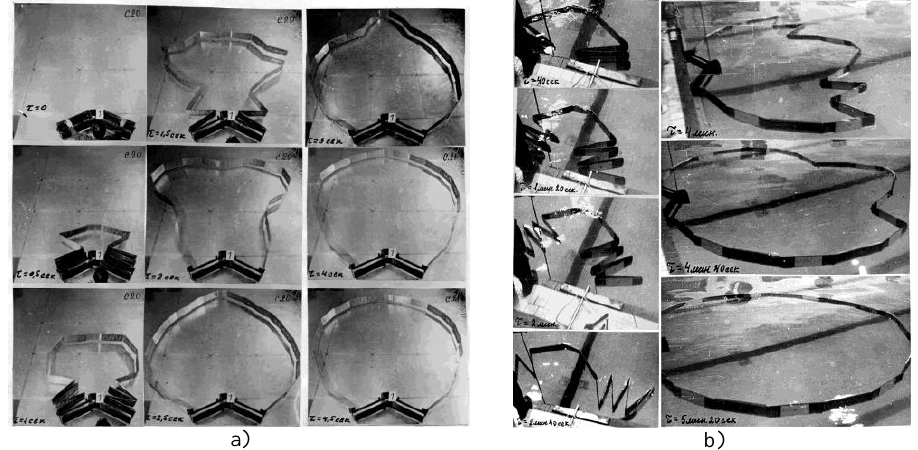
Fig. 2 . On-earth experimental tests on the adjustment of the framework unfolding: a) on a flat surface; b) in a